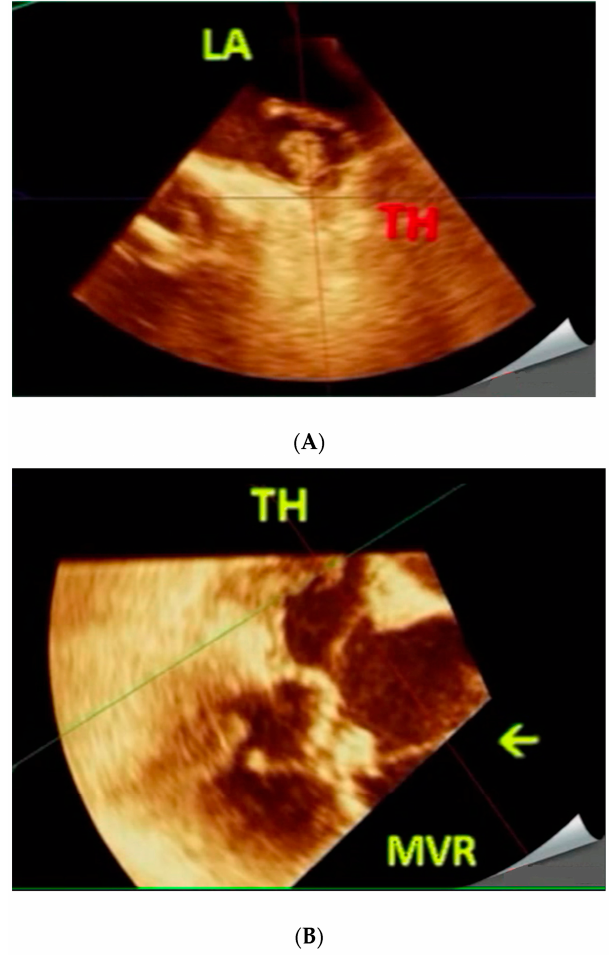
1 Figure 2. ( A , B ). 56-year-old female with severe MVR stenosis (Case 2). Pre-procedure. Live/real-time three-dimensional transesophageal echocardiography ( A , B ). A TH is noted in LAA and adjoining LA body in A. During procedure. The arrow in B points to the catheter deployment device passing through MVR avoiding the TH. Abbreviations as in Figure